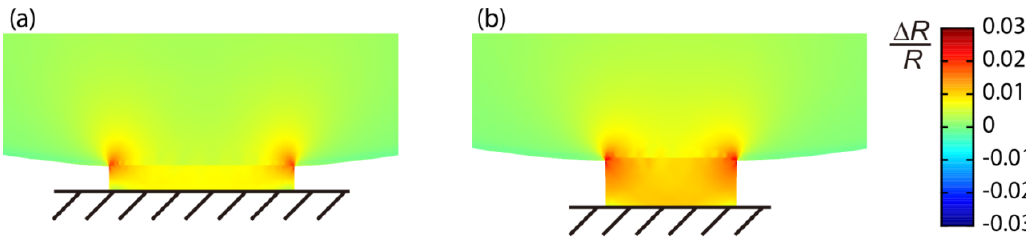
Figure 3. FEA of the distribution of Δ R / R on the R beams of ( a ) 1G-MSS and ( b ) 2G-MSS. 2 Beam sizes: (length × width × thickness): 1G-MSS chip 5 × 36 × 3.2 μ m 3 ; 2G-MSS chip 10 × 26 × 2.5 μ m 3 . In this simulation, only the structural components, e.g., the membrane and beams, are included. Note that the legend is valid for both (a) and (b) and is also the case for Figures 4 and